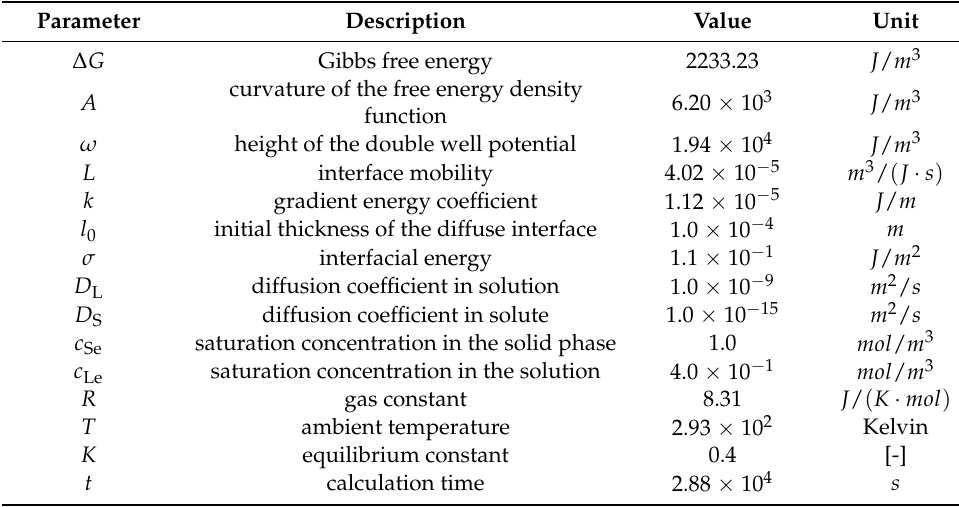
Table 1. Summary of benchmark